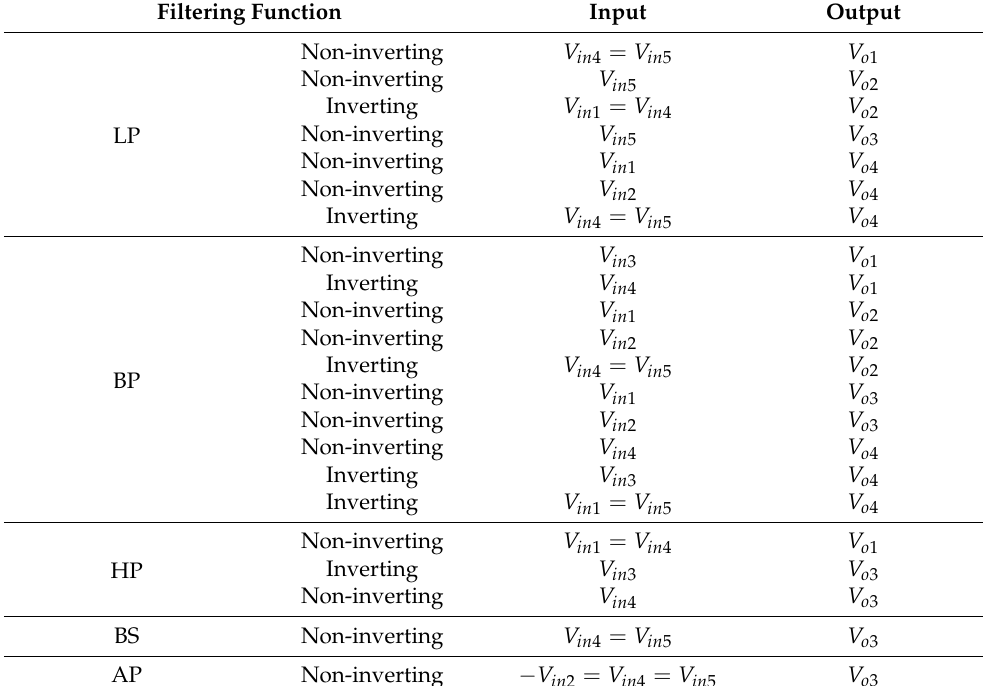
Table 1. Obtaining variant filtering functions of the proposed